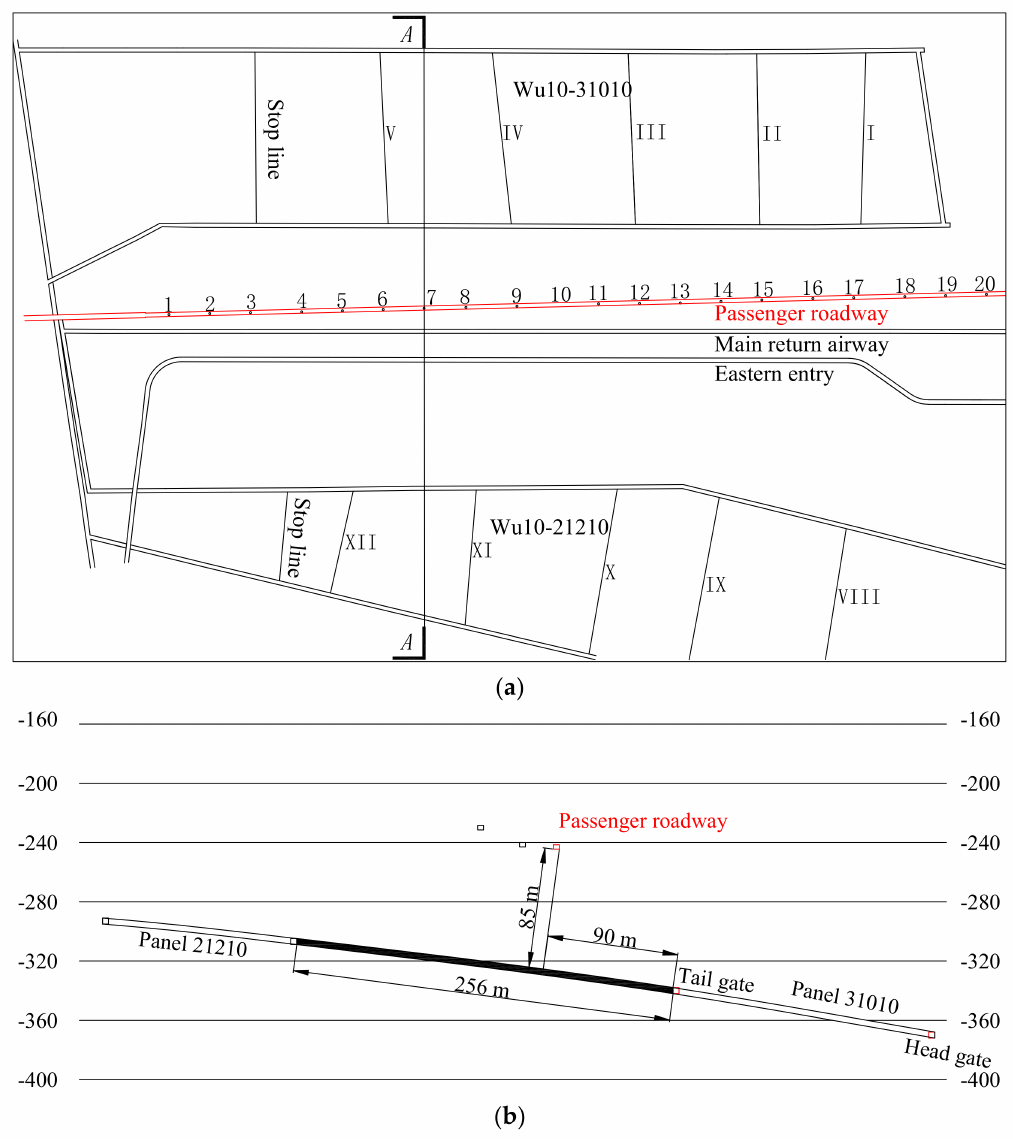
Figure 13. Relationship between location of roadway and panels. ( a ) Plan view of passenger roadway and panels; ( b ) A - A cross